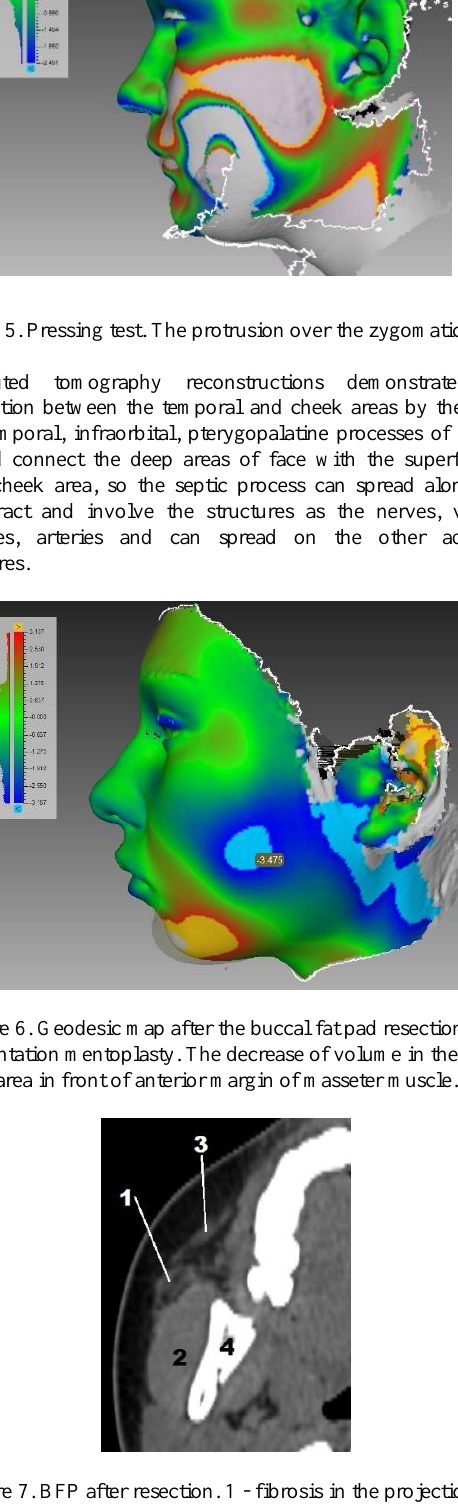
Figure 7. BFP after resection. 1 - fibrosis in the projection of BFP; 2 – masseter muscle; 3 – parotid duct; 4 –